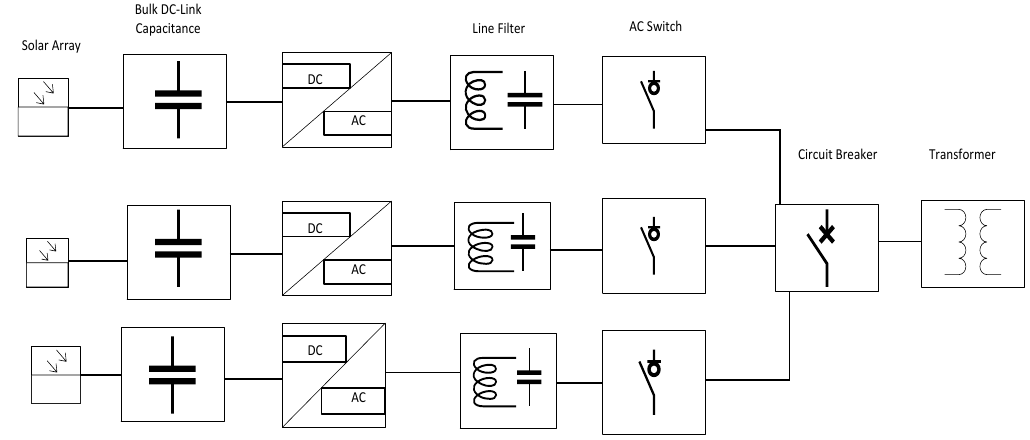
Figure 6. Schematic of a typical central PV system.